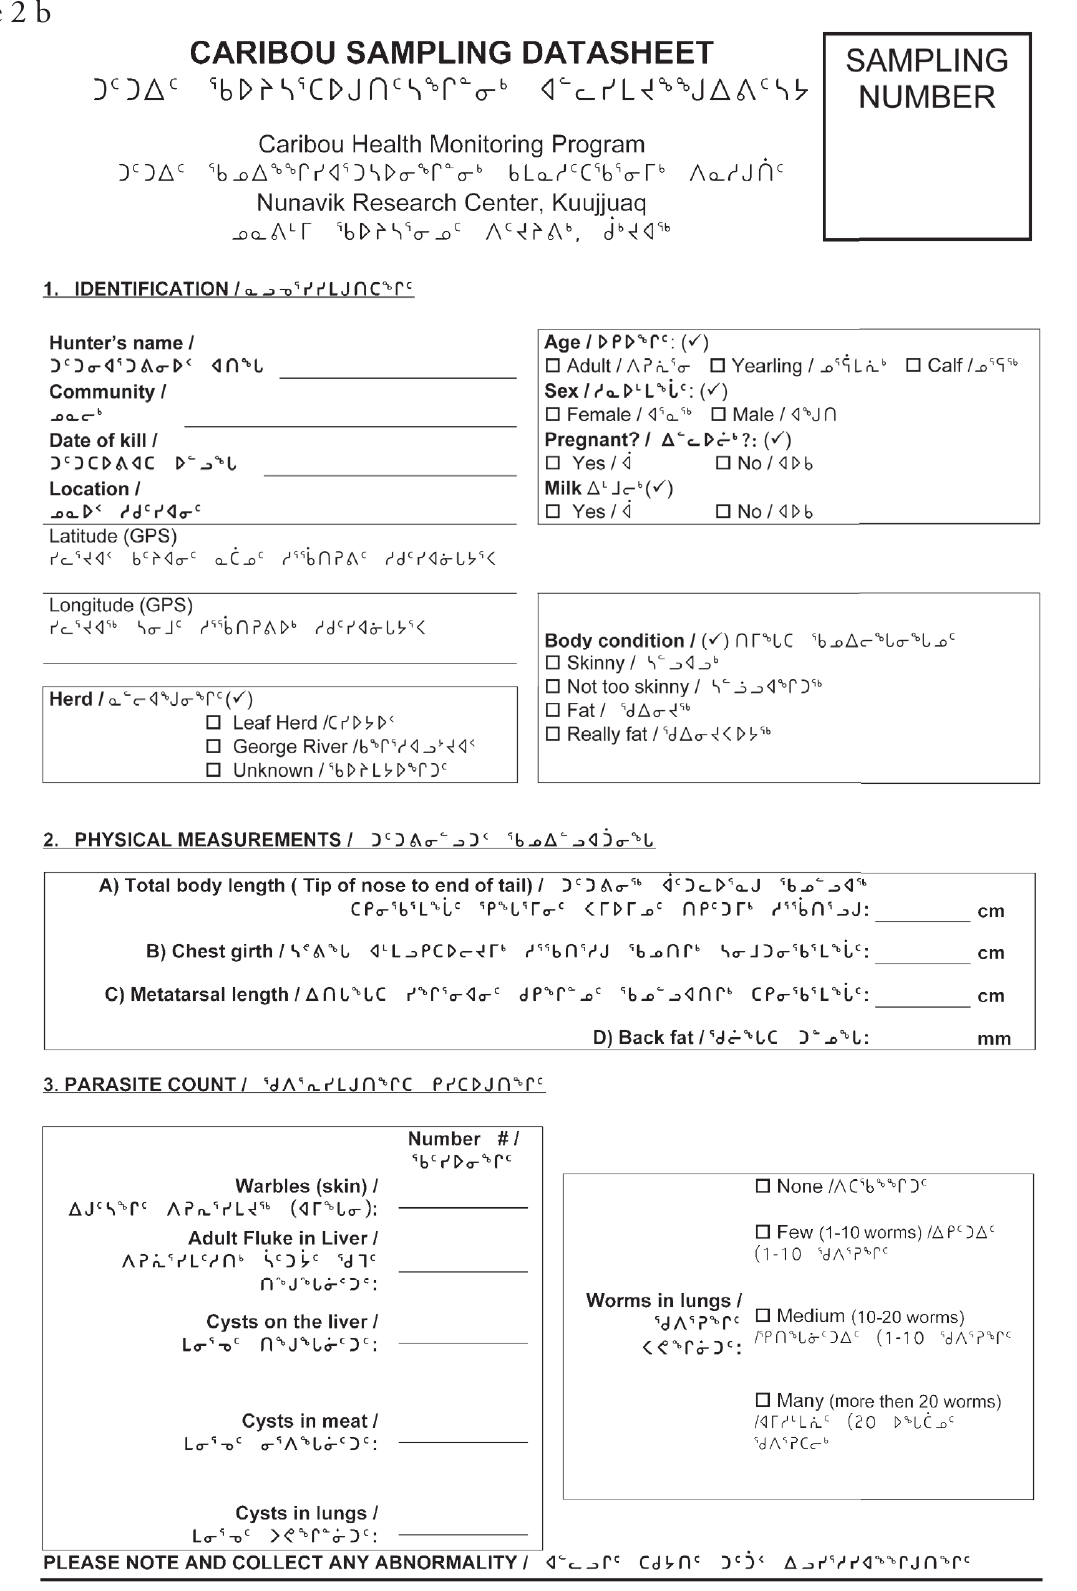
Fig. 2. Field data recording: (a) example of a Level 1 double-sided Tyvek® tag used to collect basic in- formation and identify samples, and (b) example of a Level 2 field datasheet used for the hunter-based sampling activities in Nunavik,